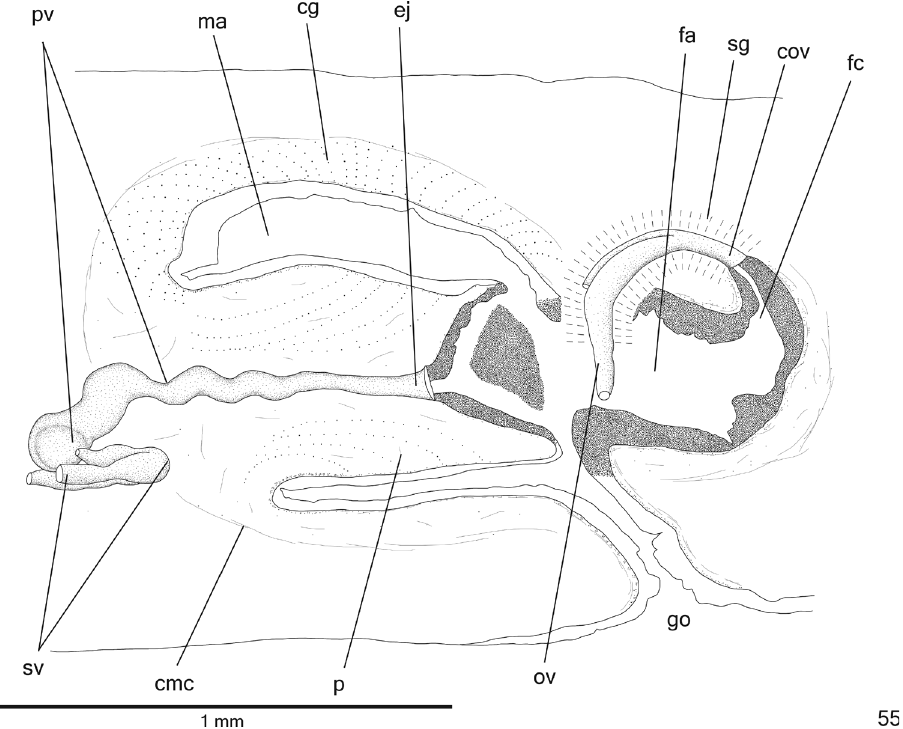
Figure 55. Cratera aureomaculata sp. n., holotype, sagittal composite reconstruction of copulatory ap-